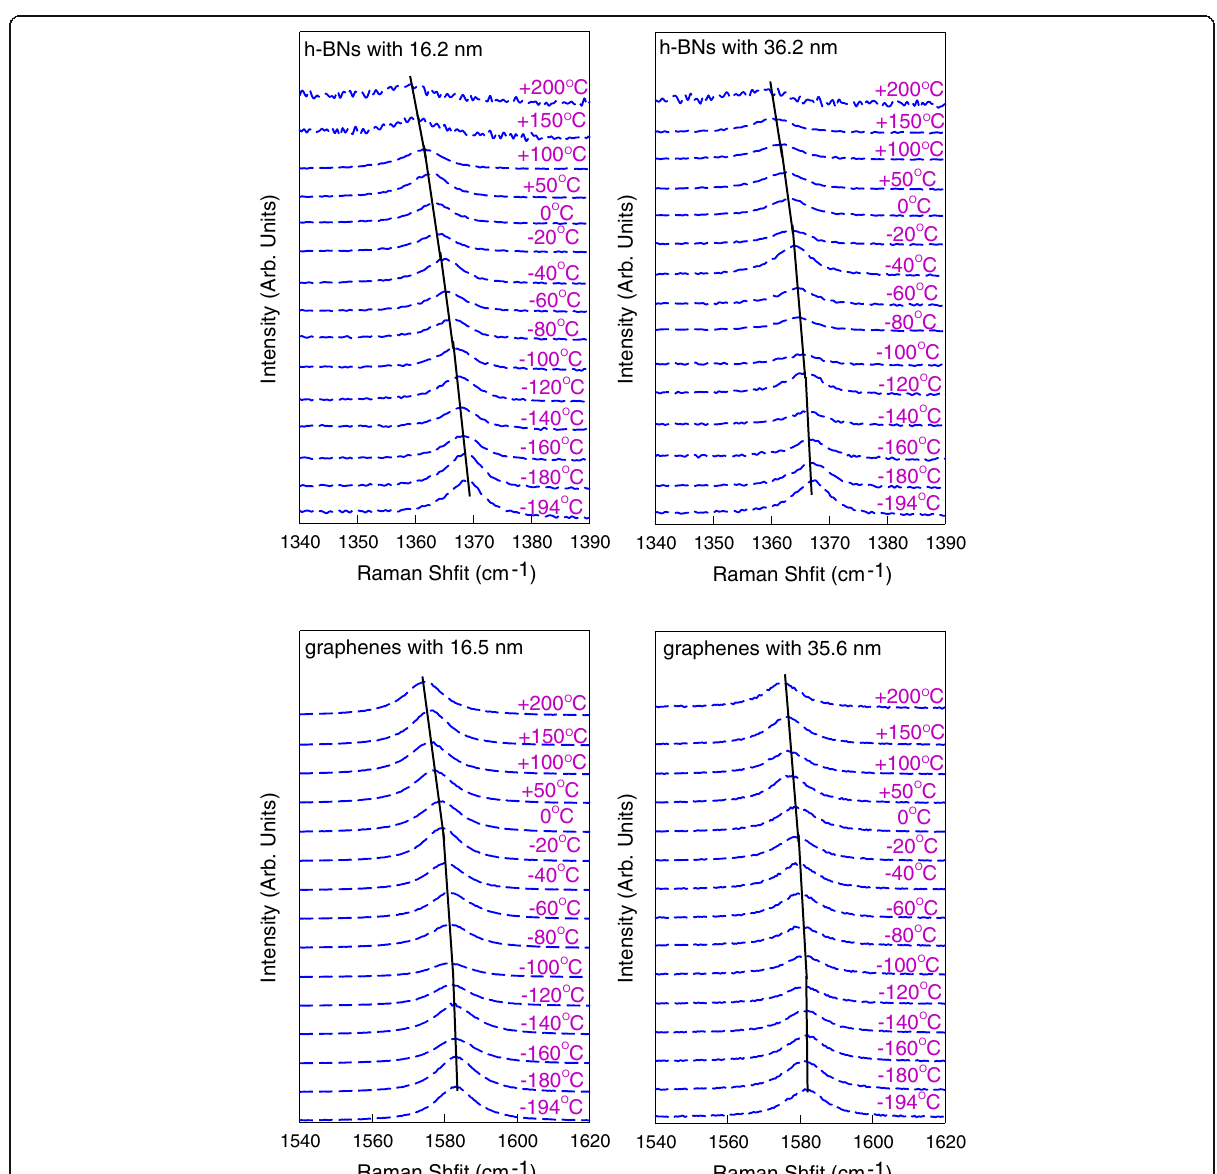
Fig. 3 Intensity-normalized Raman spectra of E 2ghigh peaks in h-BN flakes and G peaks in graphene flakes for the temperature range of − 194~200 °C. The curves are vertically shifted for